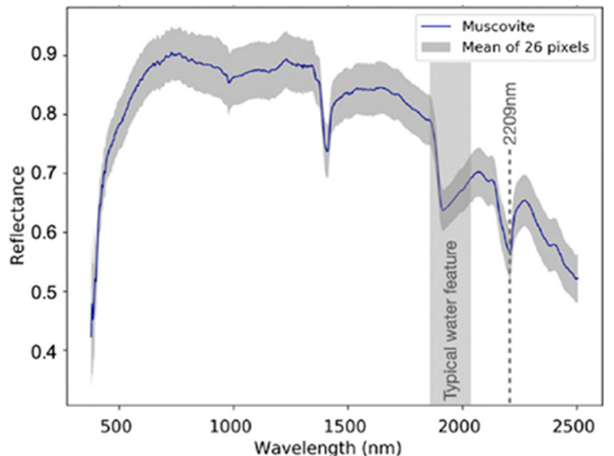
Figure 3. VNIR-SWIR spectra of muscovite/white mica spectrum, reproduced from [43], Copyright 2022